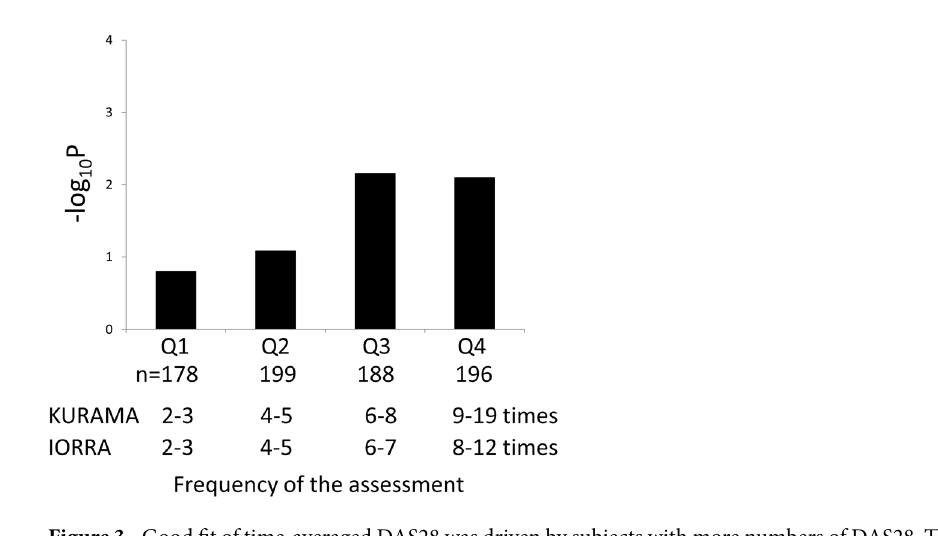
Figure 3. Good fit of time-averaged DAS28 was driven by subjects with more numbers of DAS28. The bar charts indicate − log 10 empirical P-values of R 2 of time-averaged DAS28 in each quadrant based on the number of time points of